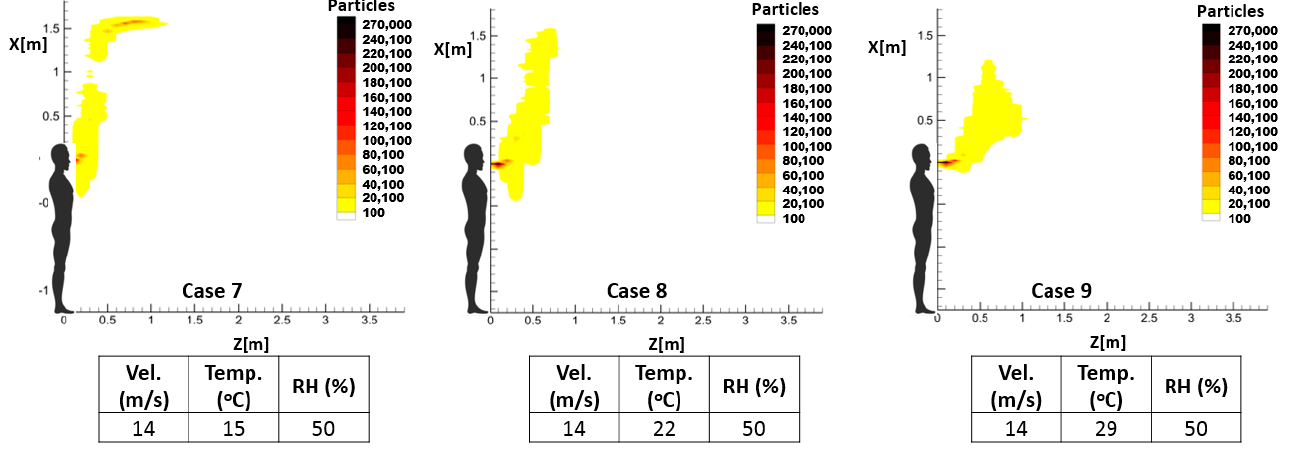
Figure 13. Risky regions with more than 100 accumulated droplets from cough cases 7 to 9 after 60 s.